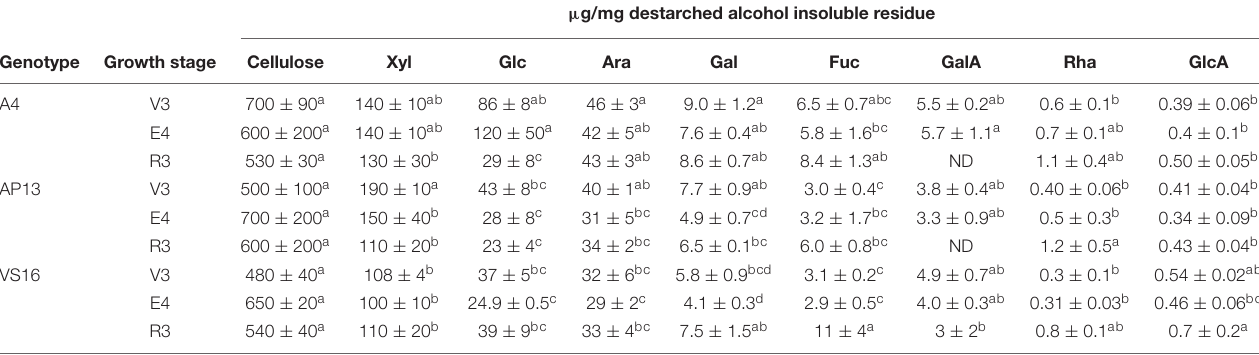
µ g/mg destarched alcohol insoluble residue